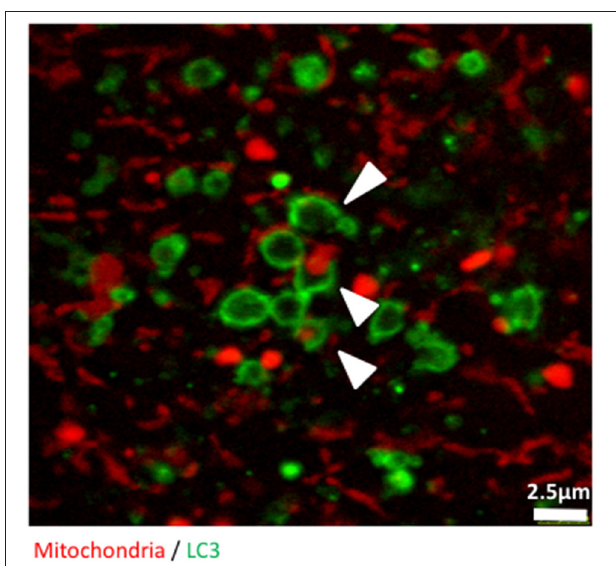
FIGURE 3 | The early stages of mitophagy can readily be demonstrated in RedMIT-GFP-LC3 MEFs. RedMIT-GFP-LC3 MEFs were cultured in glucose-free galactose media (galactose). After fixation, the cells were imaged using a Leica SP5 confocal microscope with a 63X lens and further digital zoom when needed. Autophagosomes forming around a mitochondrion are observed under these “energetic stress” growth conditions. The white arrowheads show different phases of autophagosome formation (green) around mitochondrial cargo (red). Similar observations in whole cells images have been made in Liao et al.